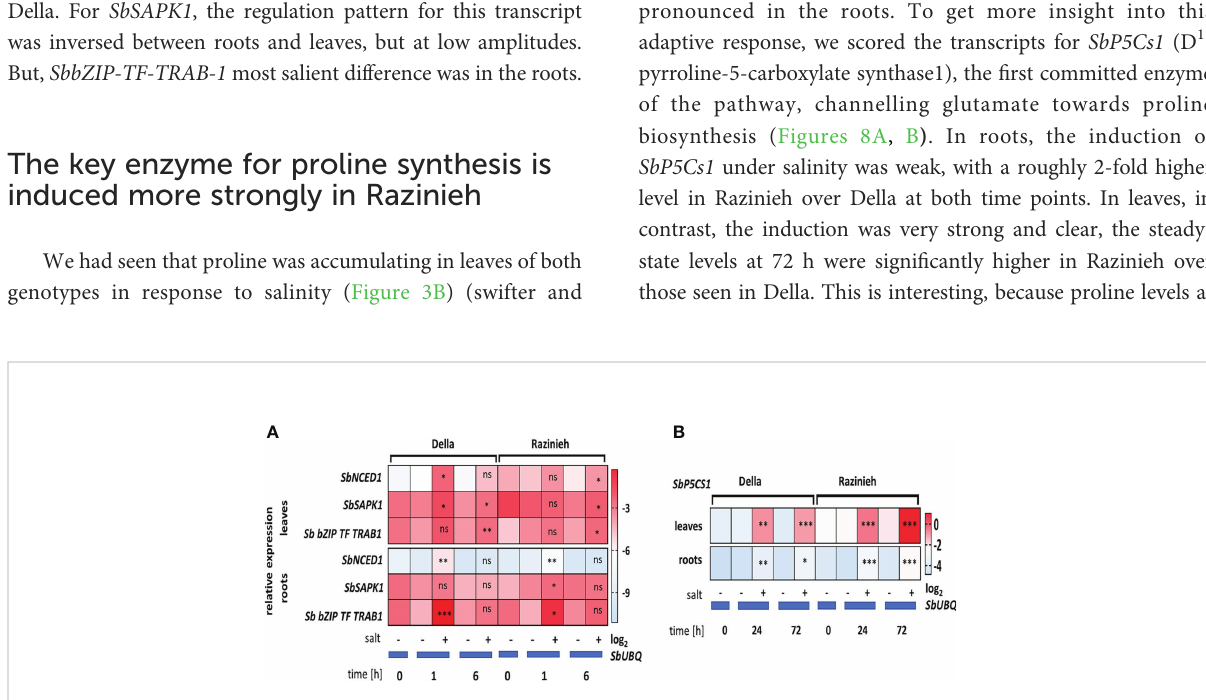
FIGURE 8 Heat maps representing the Log 2 fold change of steady-state transcripts level of stress-related genes in response to salinity (A) SbNCED1 , SbSAPK1 , bZIP-TF-TRAB1-like and (B) SbP5Cs1 . Thirteen days old Della and Razinieh seedlings were treated with 100 mM NaCl for 1, 6, 24 and 72 h. Values represent the mean of at least three independent biological replicates ± SE. Asterisks indicate a statistically signi fi cant difference between treatment and corresponding control, as determined by Student ’ s t -test (* P < 0.05, ** p < 0.01, *** P < 0.001, and ns non-signi fi cant).